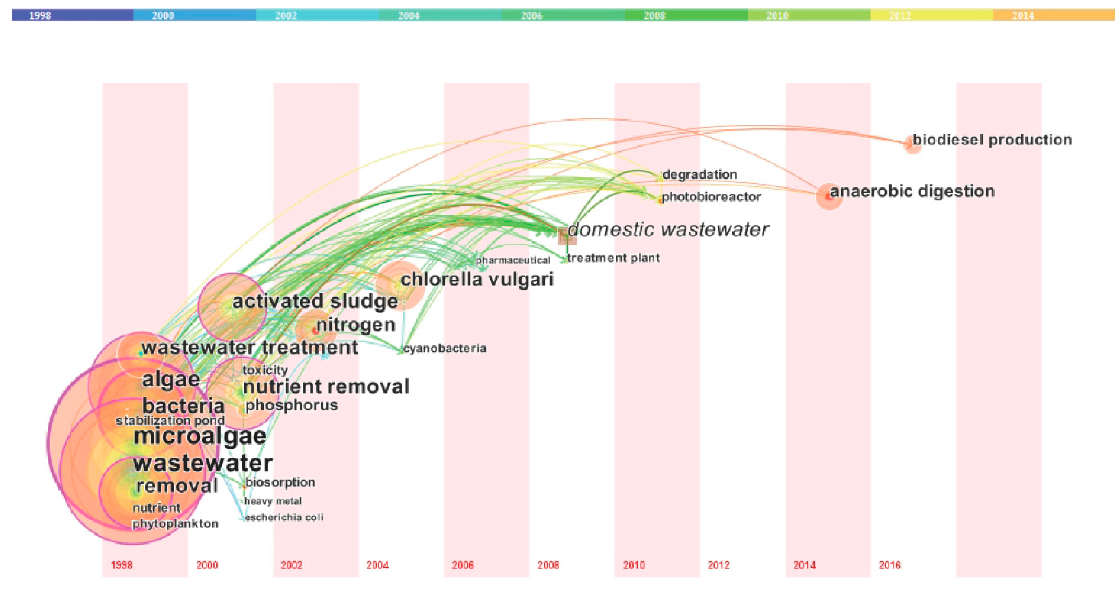
Figure 5. Timezone view based on co-occurring keywords during 1998–2017.